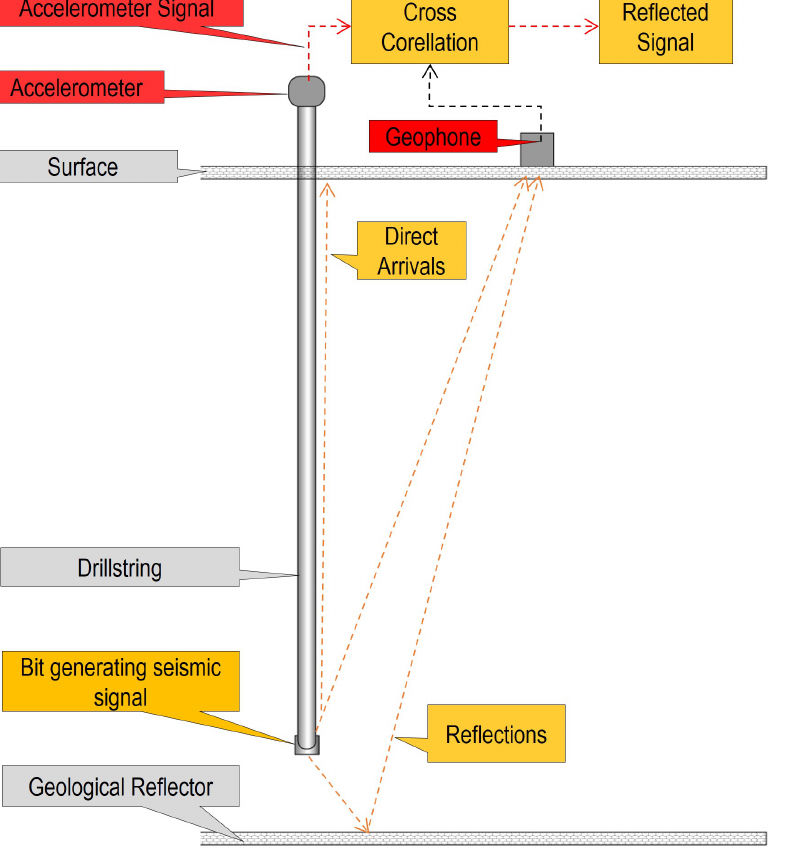
Figure 13. Schematic view of seismic while drilling signal acquisition—based on